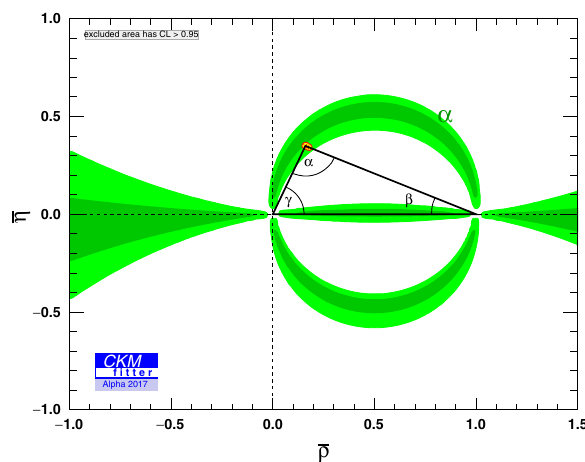
Fig. 11 95%CL( darkgreen )and68%( lightgreen )constraintson α in the( ¯ ρ, ¯ η) planefromthecombined SU ( 2 ) isospinanalysisof B → ππ , B → ρρ and B → ρπ (Dalitz) decays. The small yellow area indicates the 95% CL region for the apex of the B -meson unitarity triangle ( solid black lines ) from the global CKM fit excluding the charmless B → hh data used in the direct α determination